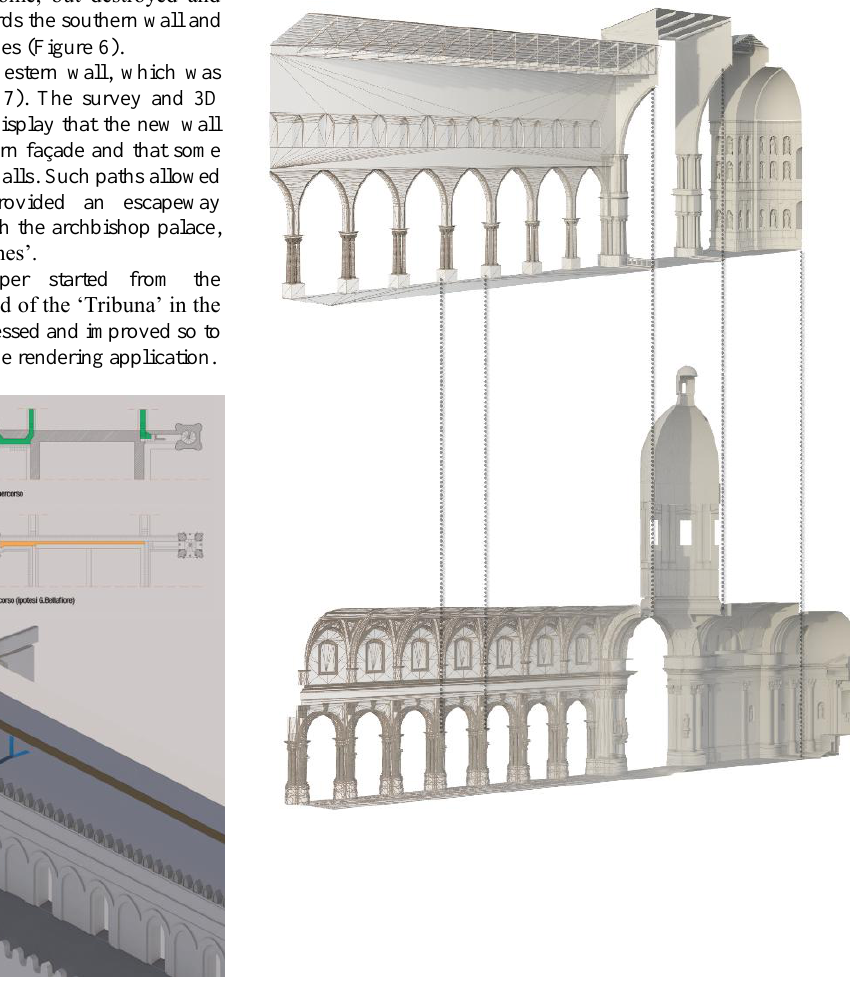
Figure 7: Reconstruction of the western